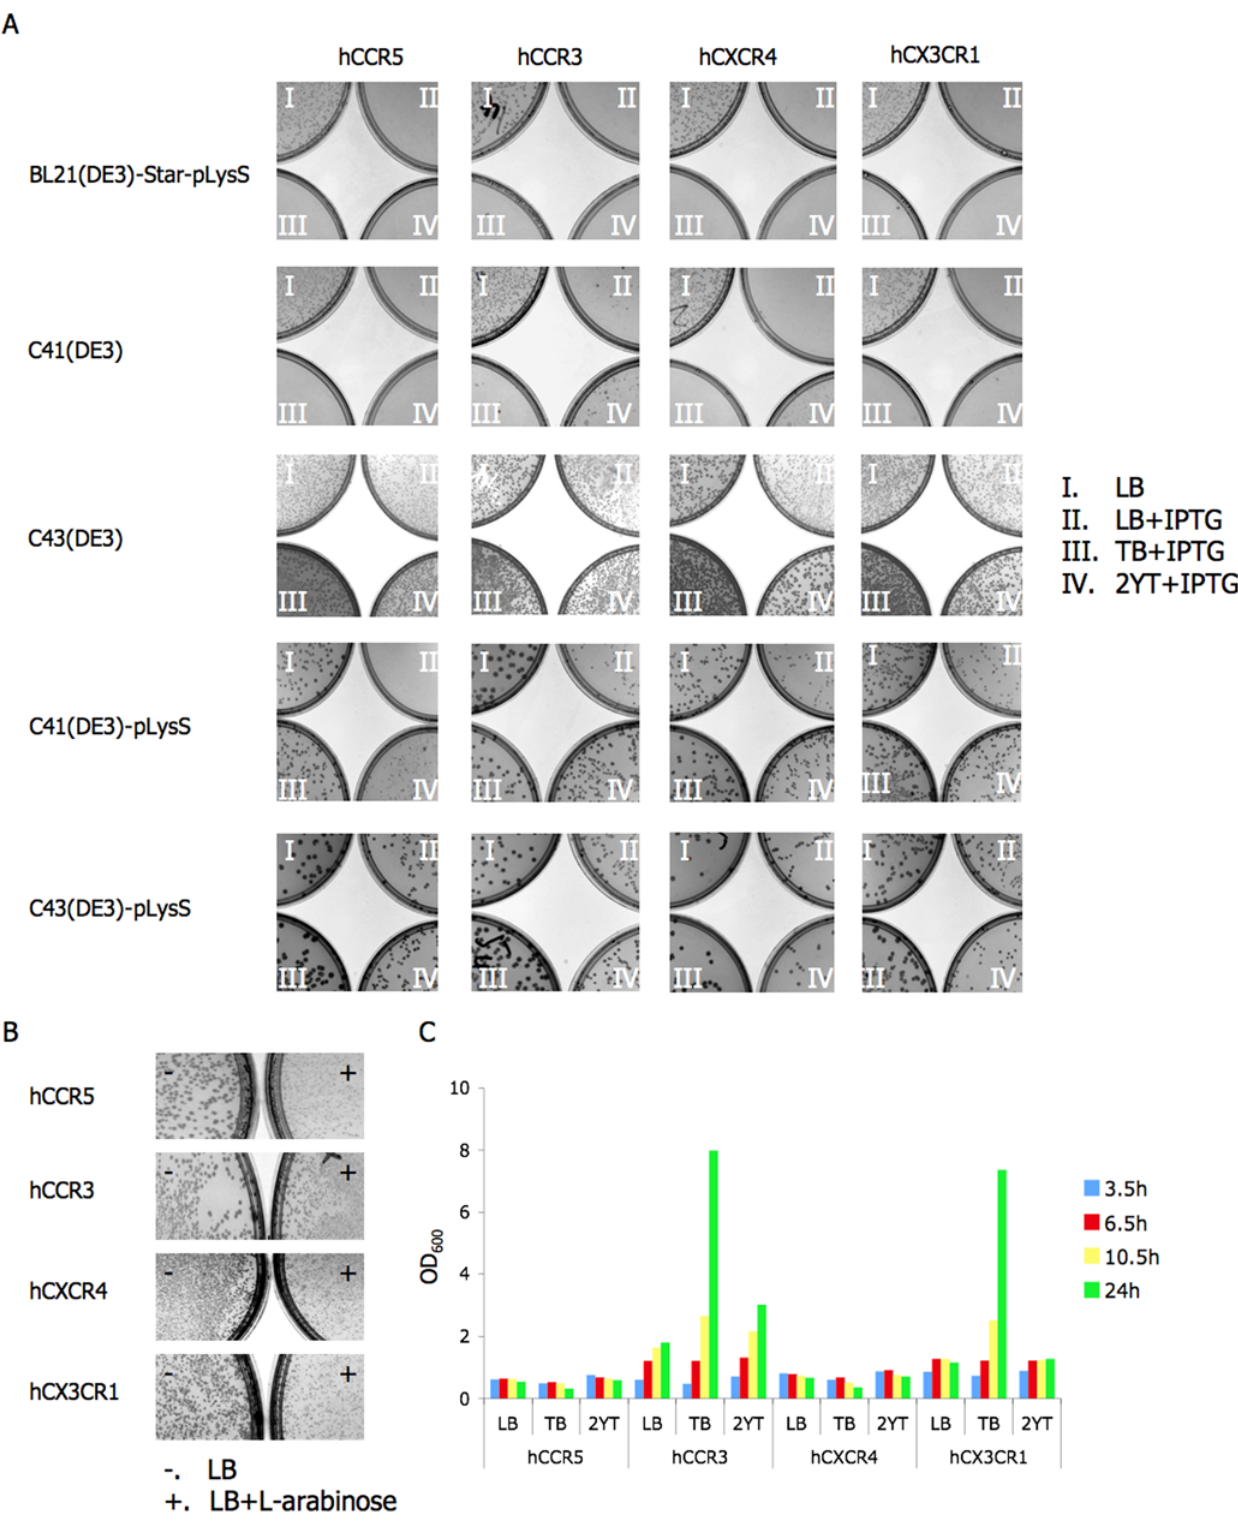
Figure 3. Selection of E.coli host strains and media for inducible expression of hCRs. A) Screening of E.coli strains and media for pEXP- hCRs. Each of pEXP-hCRs was transformed into all 5 E.coli strains: BL21, C41, C43, C41-pLysS and C43-pLysS, and spread on LB-agar plates (I), LB-agar- IPTG plates (II), TB-agar-IPTG plates (III) and 2YT-agar-IPTG plates (IV) for colony analysis. B) L-arabinose induction pBAD-hCRs for E.coli strain Top10. LB-agar plates without ( 2 ) and with ( + ) L-arabinose (0.05%) were used. C) Growth conditions of pBAD-hCRs in Top10 in the presence of inducer. Cell culture density at 600 nm (OD 600 ) after indicated induction time, 3.5 hours, 6.5 hours, 10.5 hours and 24 hours, was measured.